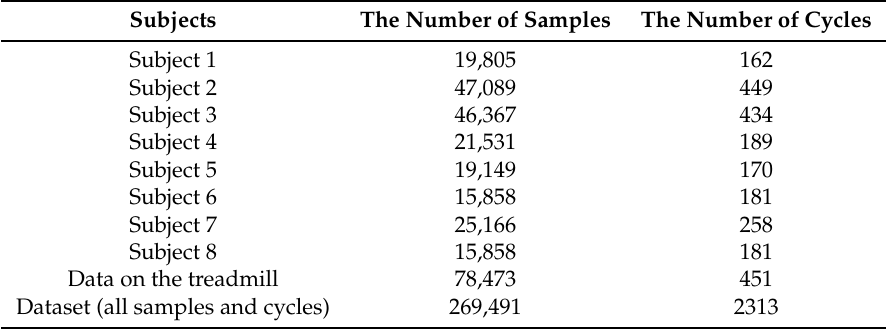
Table 2. The number of samples and cycles in the dataset.